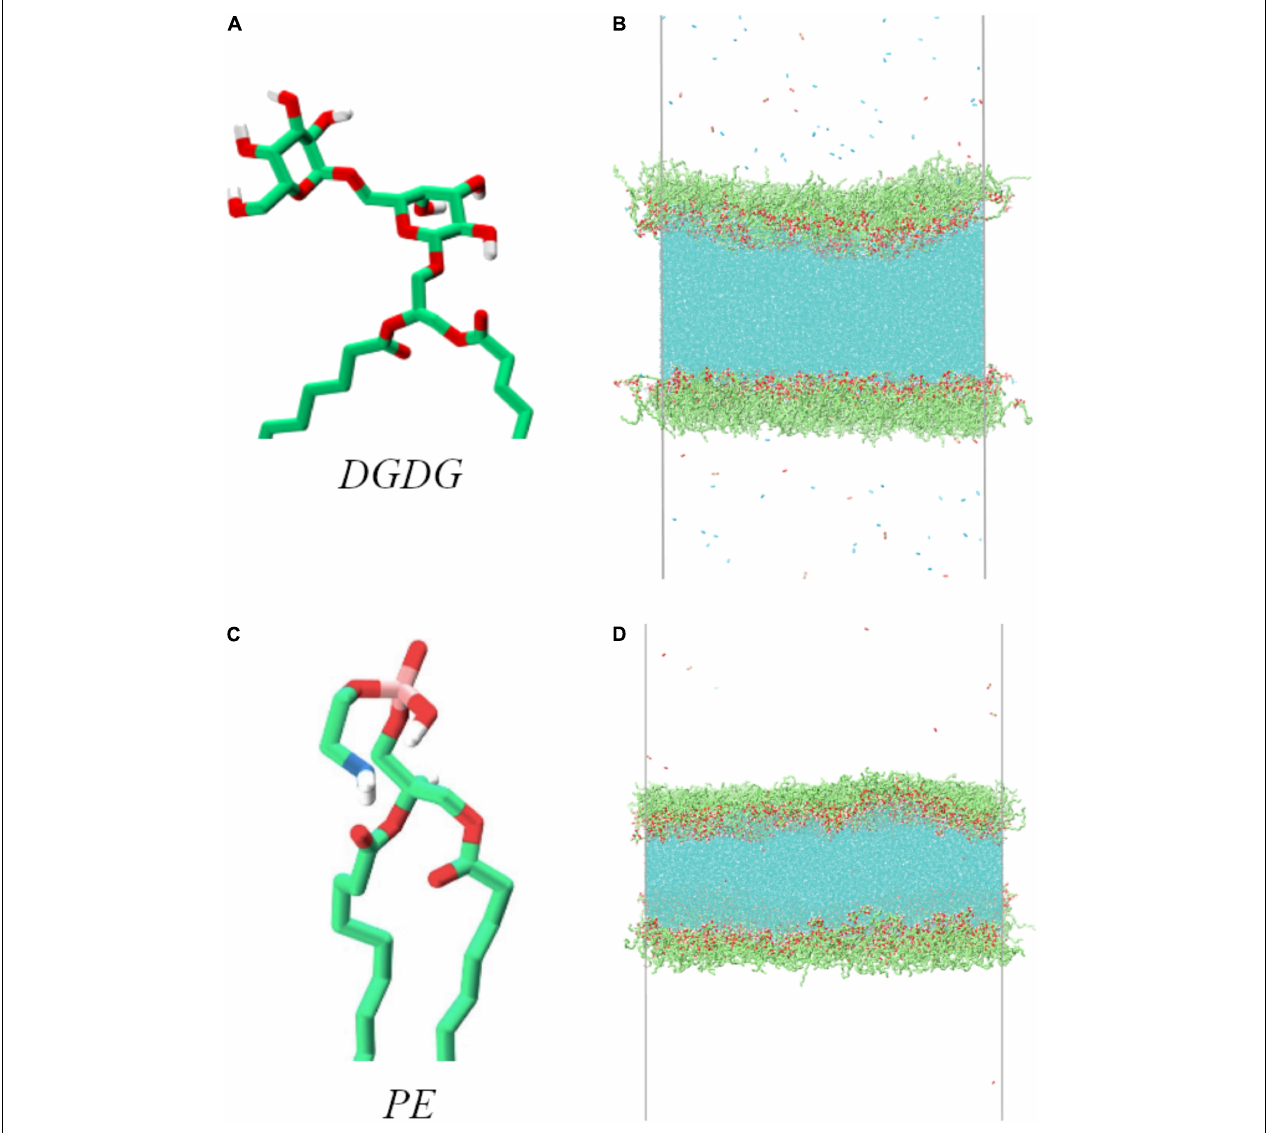
FIGURE 1 | Head group structure of the two lipids used in this work, alongside atomistic representations of the equilibrated simulation boxes: digalactosyldiacylglycerol (DGDG, A,B ) and phosphatidyl ethanolamine (PE, C,D ). Carbon atoms and methylene groups are colored green, oxygen red, hydrogen white, nitrogen blue and phosphorus pink. Water molecules are colored cyan in (B,D)